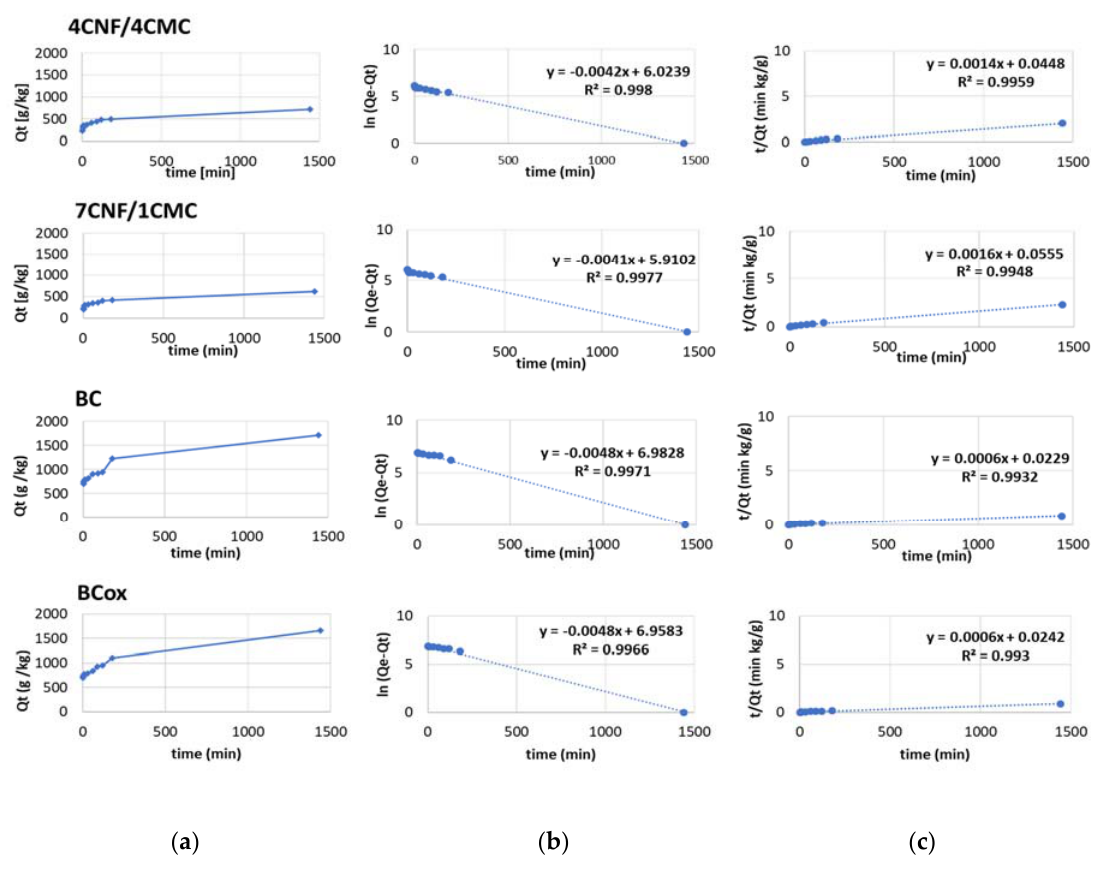
Figure 8 ( a ) Adsorption behavior of anthraquinone dye C.I. Basic Blue 47, ( b ) pseudo ‐ first ‐ order kinetic plots, and ( c ) pseudo ‐ second ‐ order kinetic plots of 4CNF/4CMC, 7CNF/1CMC, BC, and BCox membranes.